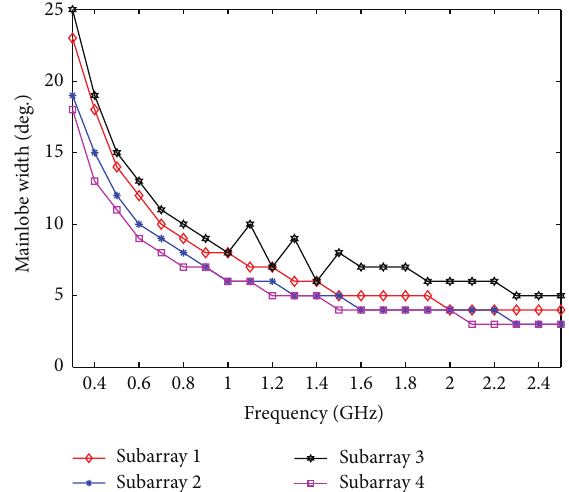
Figure 4: The curve of the relation between the carrier frequency and main-beam